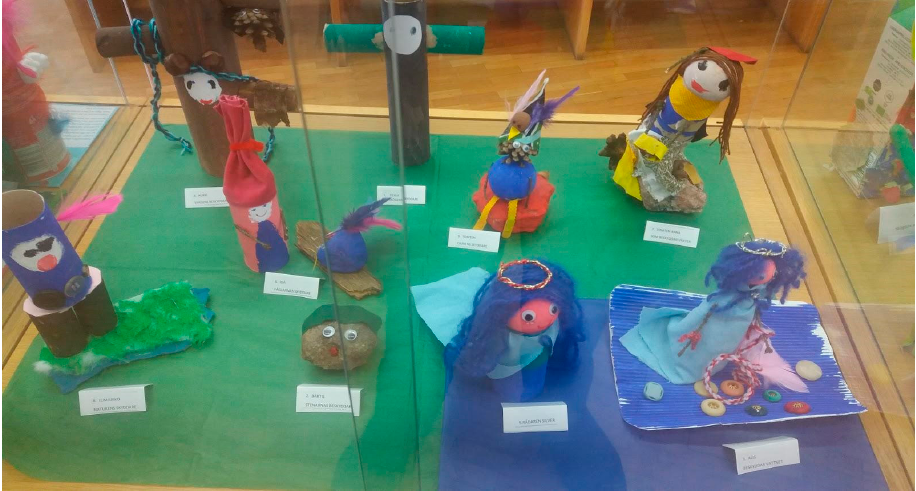
Figure 3. Spirits of the Forest exhibition.